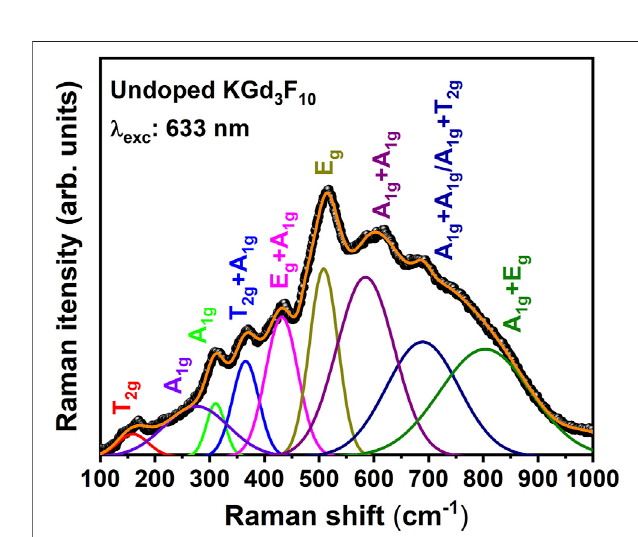
FIGURE 2 | XRD pattern of the 5% Er 3+ , 20% Yb 3+ : KGd 3 F 10 particles (black circles) and reference pattern of KYb 3 F 10 provided by the ICSD online database (red vertical lines).